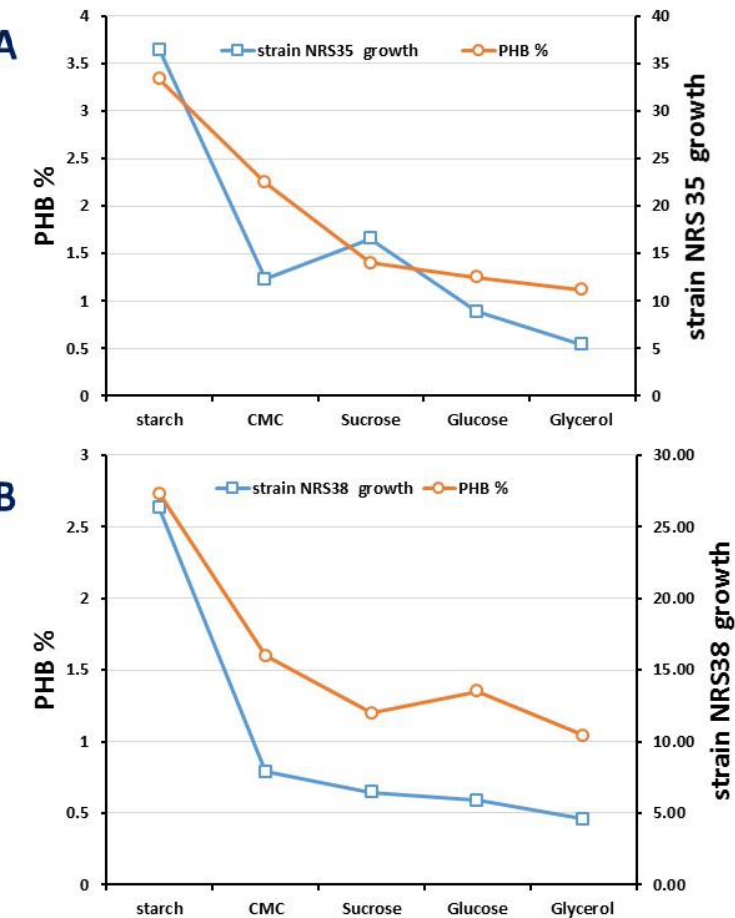
Figure 4. Growth and PHB yield by two new isolates Halolamina ( A ) NRS_35 and ( B ) NRS_38 under similar conditions with different carbon sources.